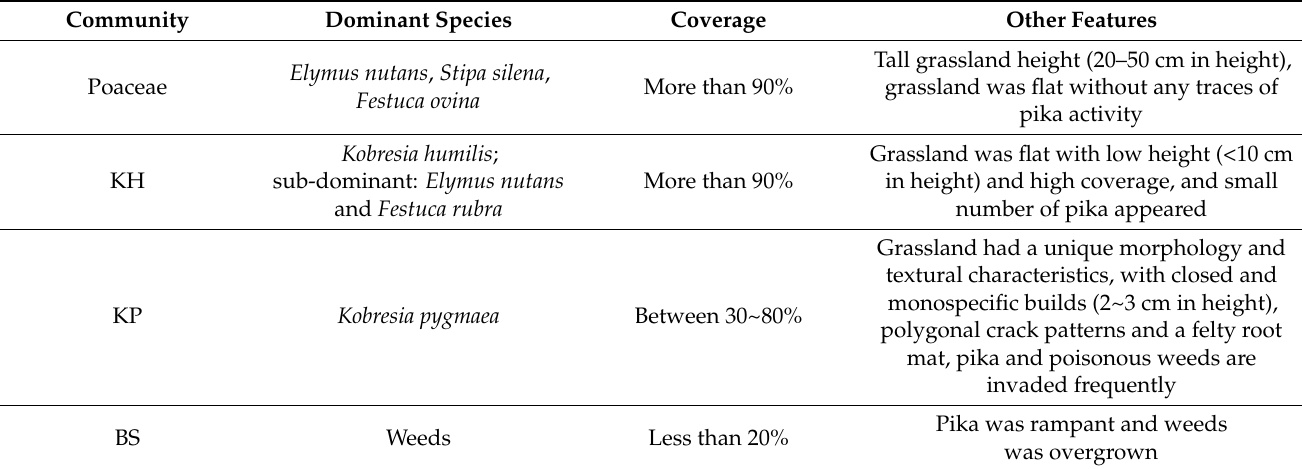
Figure 3. Classification criteria for aerial photographs of alpine meadow vegetation communities. ( a , e , i , m ) were aerial photographs taken at the height of 20 m by Phantom 3. ( b , c , f , g , j , k , n , o ) were aerial photographs taken at a height of 2 m by Mavic 2. ( c , g , k , o ) acquired with 2 × wide-angle zoom lenses; ( d , h , l , p ) were Gaofen images of four types of vegetation communities corresponded; Poaceae, KH, KP and BS represented communities of Elymus nutans + Stipa silena + Festuca ovina , Kobresia humilis , Kobresia pygmaea and black soil type, respectively. Table 1. Characteristics of vegetation communities in alpine